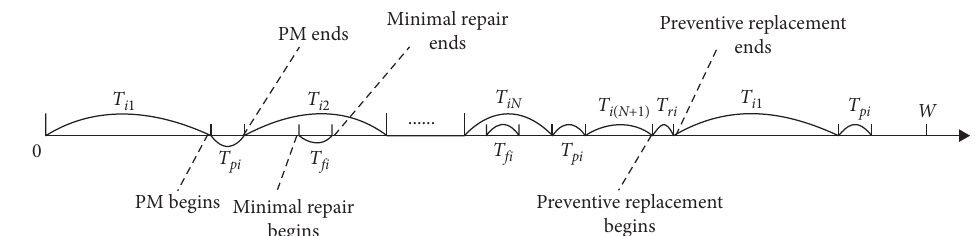
Figure 4: Preventive maintenance (PM) process for component i .